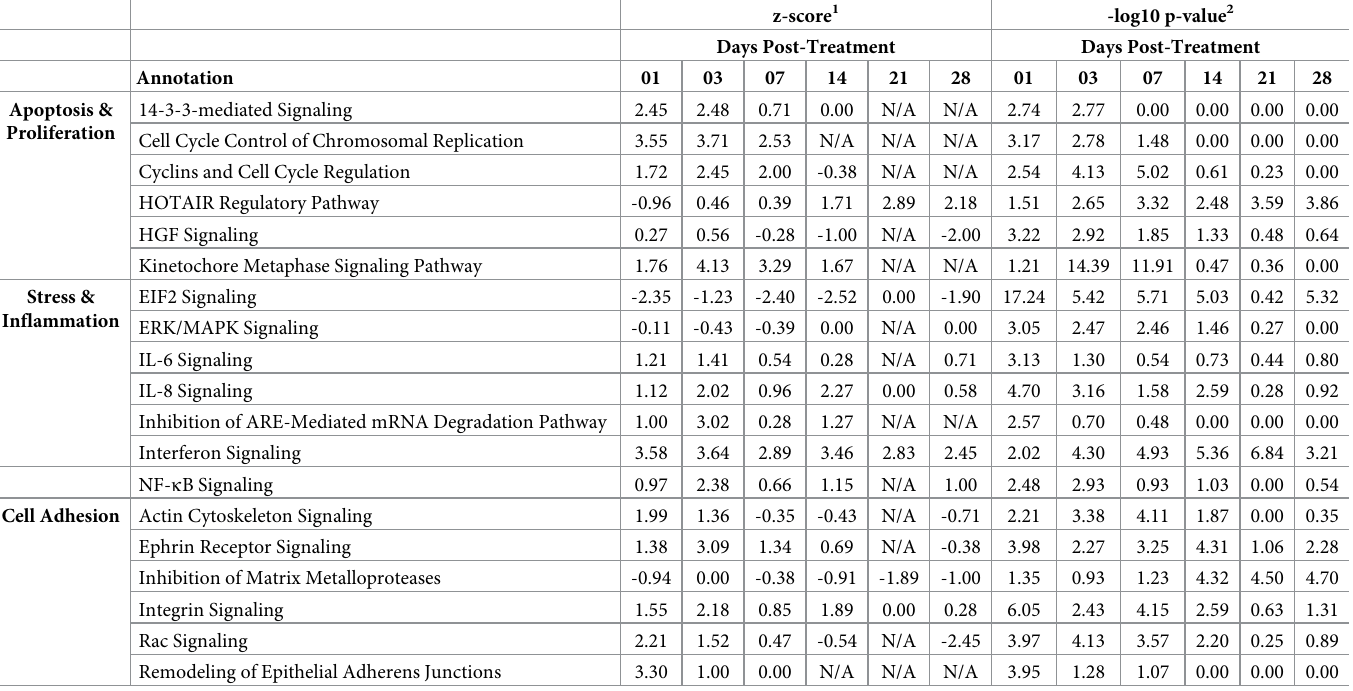
Table 6. Canonical signaling pathways associated with laser resurfacing